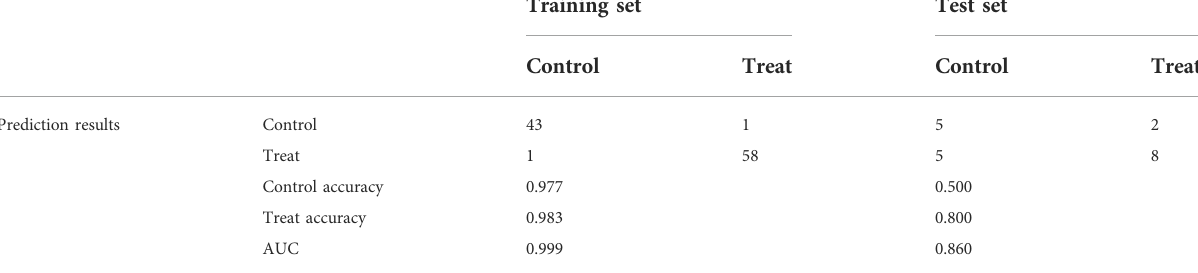
TABLE 2 Neural network diagnostics for the training and test